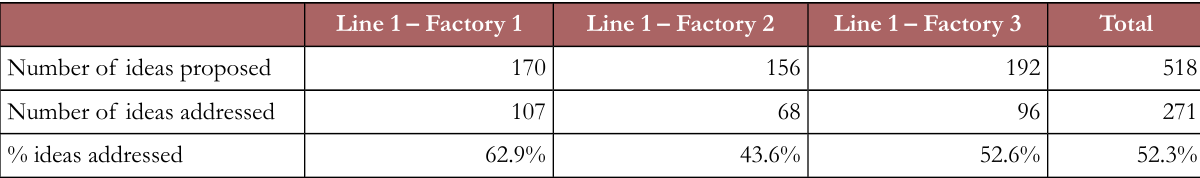
Table 2. Percentage of ideas addressed with respect to the total